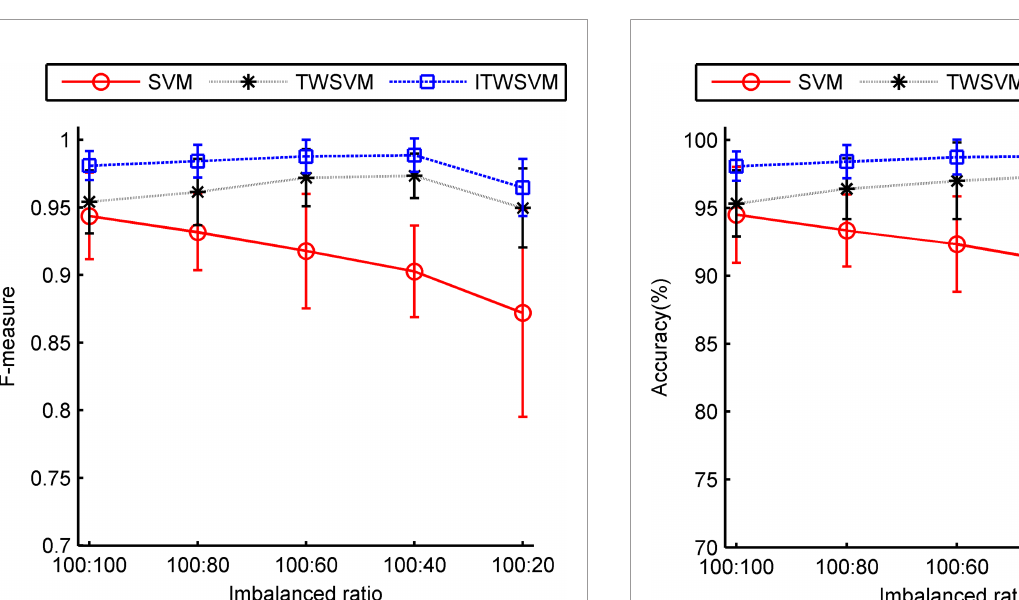
FIGURE 8 | Average and standard deviation of